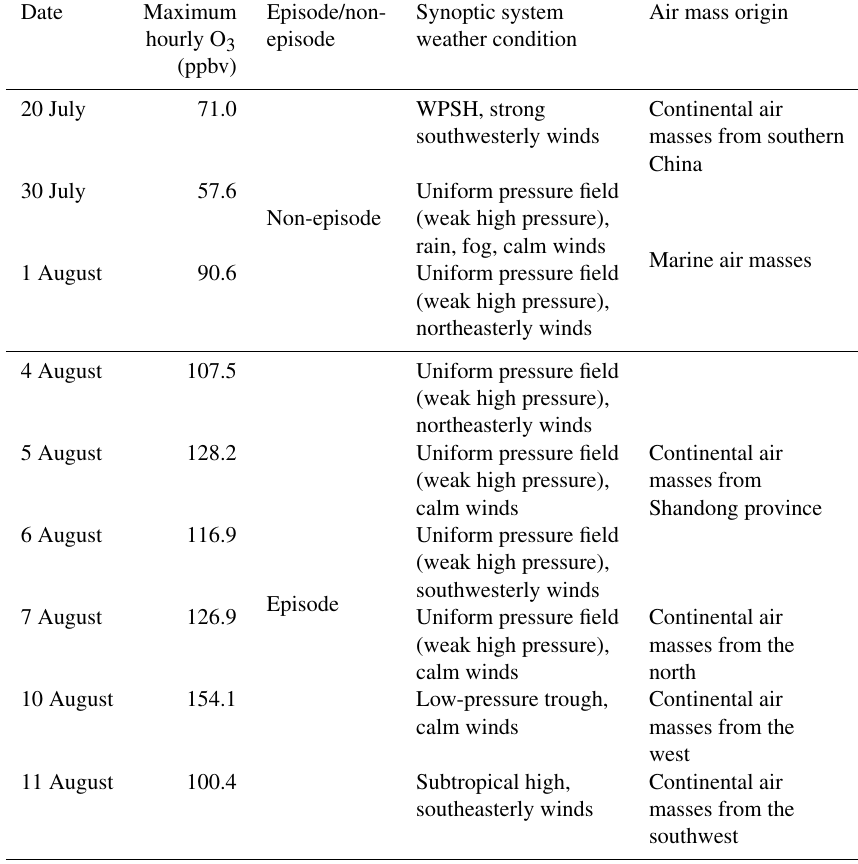
Table 1. Summary of the synoptic systems, weather conditions and air mass origins on VOC sampling